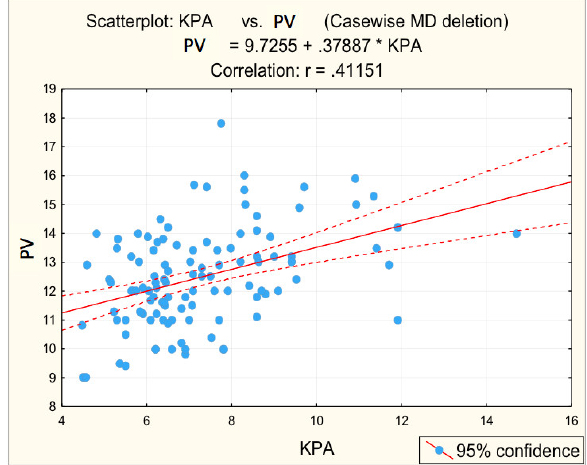
Figure 4. Correlation portal vein dimension—fibrosis .